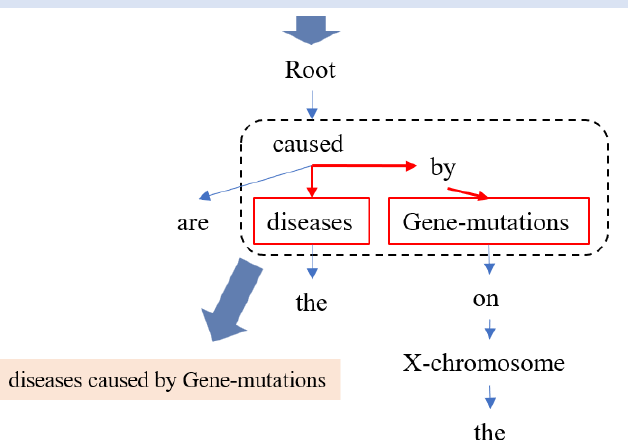
Figure 6. The structural data are constructed using the dependency tree and the shortest dependency path based on the raw sequential data.